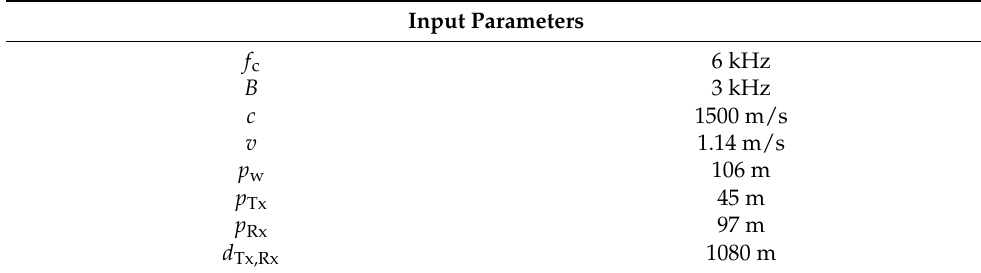
Table 6. KAU1 channel conditions used for the